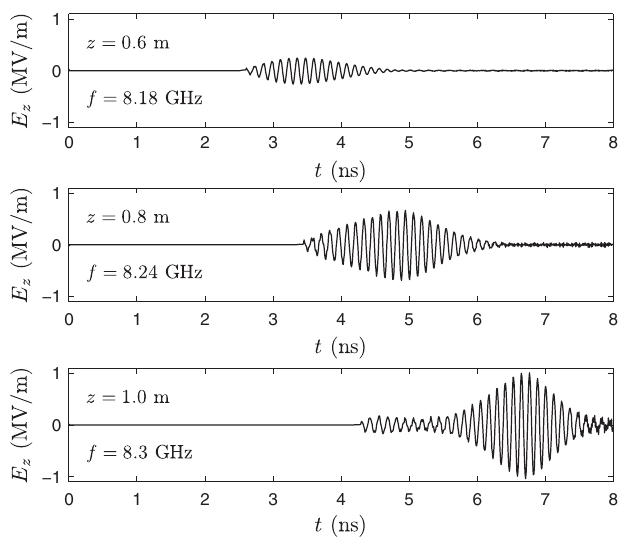
FIG. 14. Temporal pulse evolution for a 50 A beam with (cid:1) ¼ 1 showing shift in resonant frequency from 8.18 GHz in the linear regime to 8.3 GHz in the nonlinear regime as the pulse evolves.